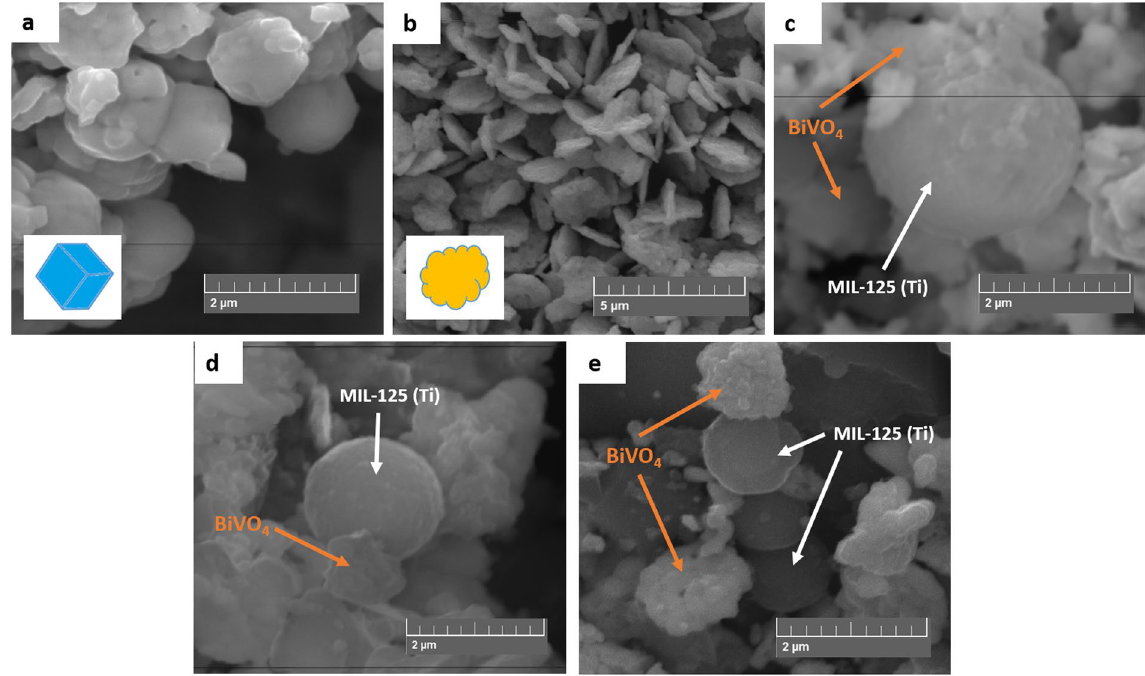
Figure 1. SEM images of ( a ) MIL-125(Ti), ( b ) BiVO 4 , ( c ) 1–1 Bi:Ti, ( d ) 2–3 Bi:Ti and ( e ) 3-2 Bi:Ti. The inserts in ( a ) and ( b ) are redrawn morphologies of the pristine MIL-125(Ti) and platelet-like BiVO 4 respectively.